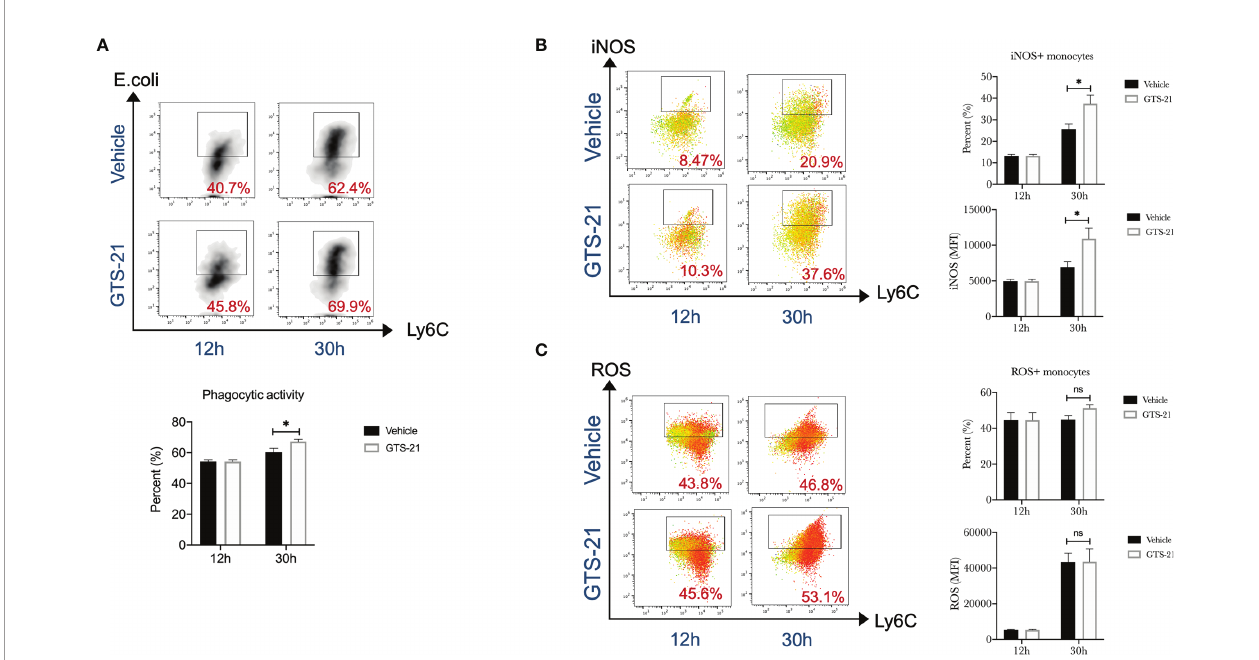
FIGURE 3 | GTS-21 treatment increases peritoneal monocytes functions during CLP-induced septic peritonitis. Mice were subjected to CLP, and GTS-21 or vehicle was injected intraperitoneally 12h after CLP procedure and repeated every 12h. At indicated intervals, peritoneal cells were harvested ( n =6~8 mice/ group). (A) After isolation, peritoneal cells were incubated with PE-labeled Escherichia coli for 2h, then labeled with monocytes markers (CD11b+Ly6G-Ly6C+), phagocytic activity was evaluated by measuring the uptake of PE-labeled Escherichia coli by fl ow cytometry as described in Materials and Methods. (B) Then, after staining for monocytes markers (CD11b+Ly6G-Ly6C+), cells were permeabilized and assessed for intracellular expression of iNOS by fl ow cytometry as described in Materials and Methods. (C) After incubating with complete media containing 5 m M/ml ROS Brite ™ for 30 minutes, monocytes were determined by cell surface markers (CD11b+Ly6G-Ly6C+), ROS expression was determined by fl ow cytometry. Results are expressed as mean ± SEM. No statistical difference (ns, P>0.05) and *p < 0.05 for GTS-21 vs